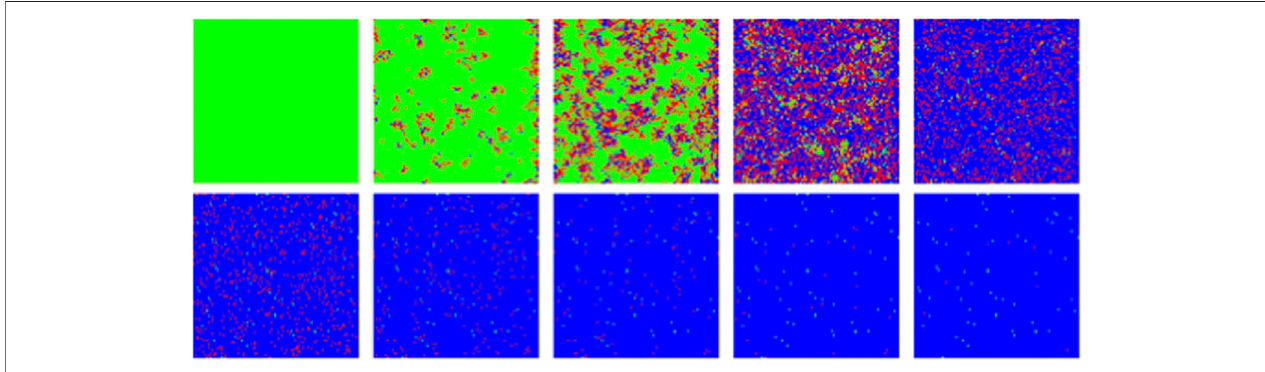
FIGURE12| MC/Spatial.Typicalevolutionofindividuals(pixels)withMCsteps(10stepsbetweenframes).Green,redandbluecorrespondtosusceptible,infected and recovered. Other parameters are: N (cid:2) 100, p i